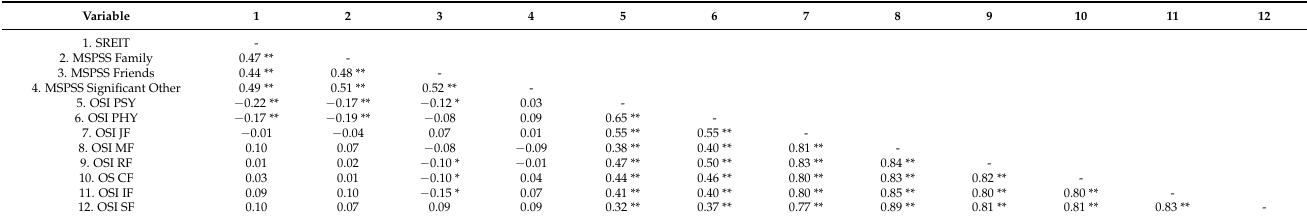
Table 2. Correlations between the study variables.